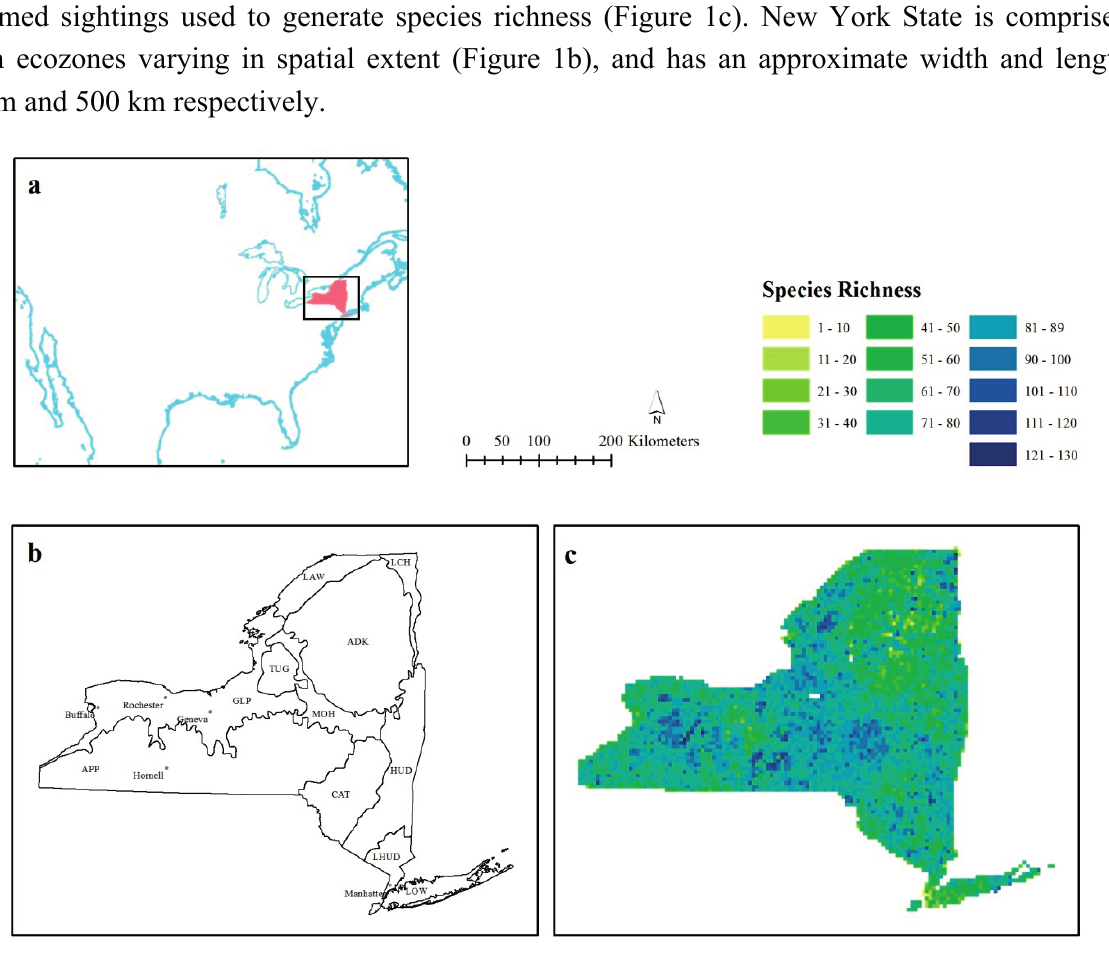
Figure 1. ( a ) New York State in relation to North America; ( b ) the study area with the eleven major ecozones. Ecozones include, the Adirondacks (ADK), Appalachian Plateau (APP), Catskills (CAT), Coastal Lowlands (LOW), Great Lake Plains, (GLP), Hudson Valley (HUD), Lake Champlain (LCH), Lower Hudson Valley (LHUD), Mohawk Valley (MOH), St. Lawrence (LAW), and Tug Hill (TUG); and ( c ) the species richness data used in the